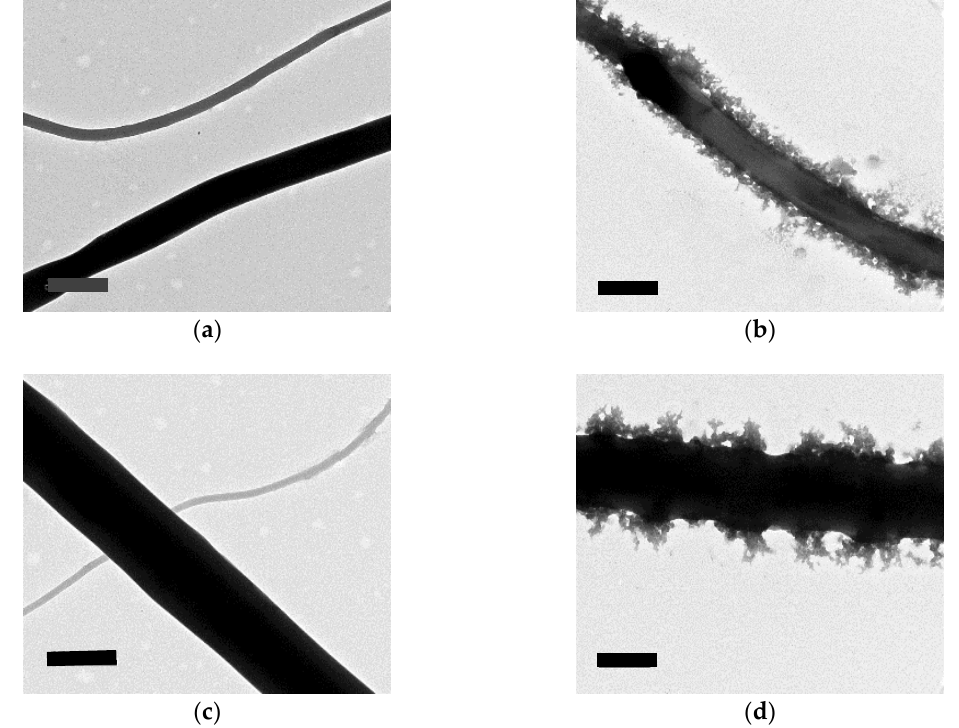
Figure 10. The arrangement of GO in the electrospun fiber from the GO-ASC-g-P(MMA-co-EA nanocomposite: TEM images of ( a ) M1-8, ( b ) M1-16, ( c ) M2-8; and, ( d ) M2-16. The scale bar shown on the bottom bar is 500 nm.